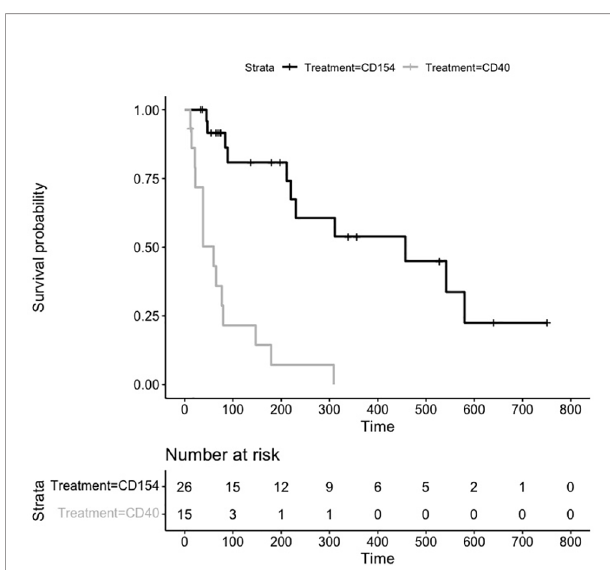
FIGURE 4 | Kaplan Meier Survival Plot and Risk Table for Treatment Durability. Kaplan-Meier estimates of the probability of rejection free survival by treatment group after discontinuation of treatment. Median survival CD40 (38 days), and CD154 (198 days) groups (P = 0.0003 log-rank